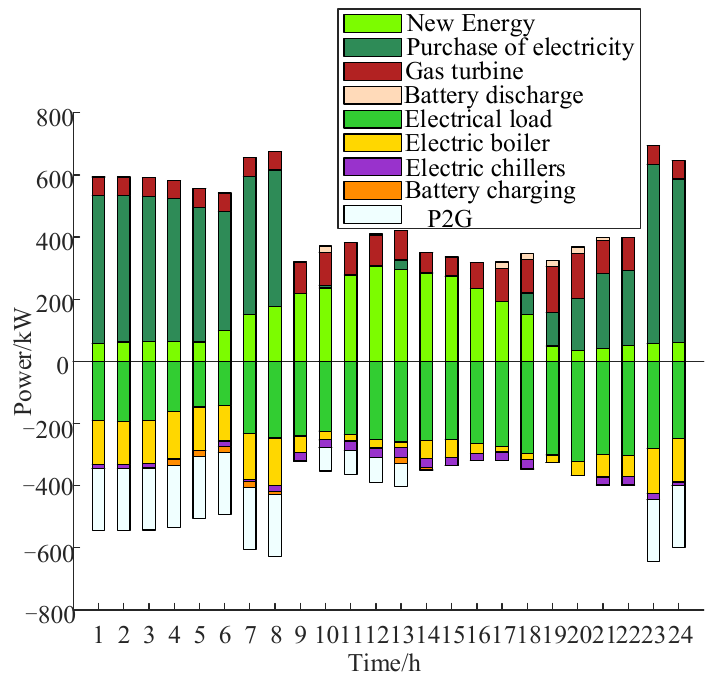
Figure 3. Electric power optimization diagram.